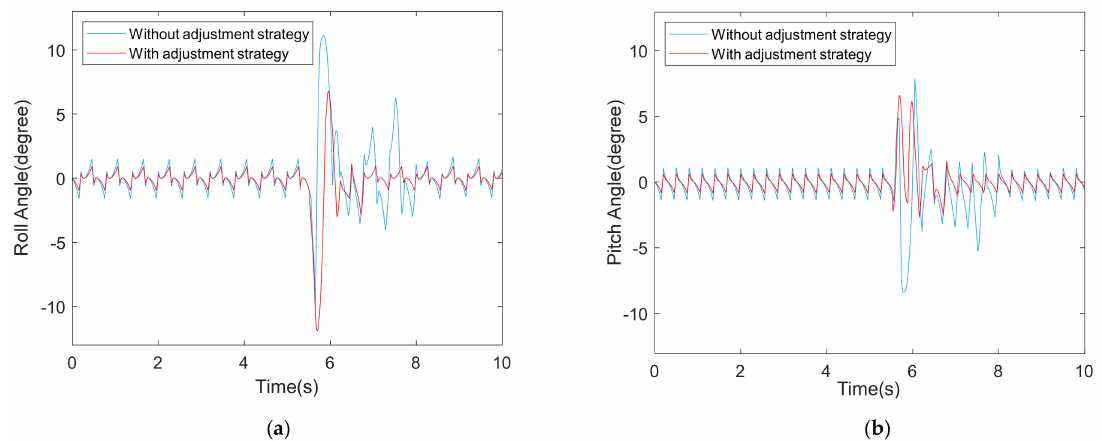
Figure 13. Lateral impact is applied to the quadruped robot as it moves in place. In ( a ), the roll angle curves of the robot without and with the adjustment strategy are compared. In ( b ), the pitch angle curves of the robot without and with the adjustment strategy are